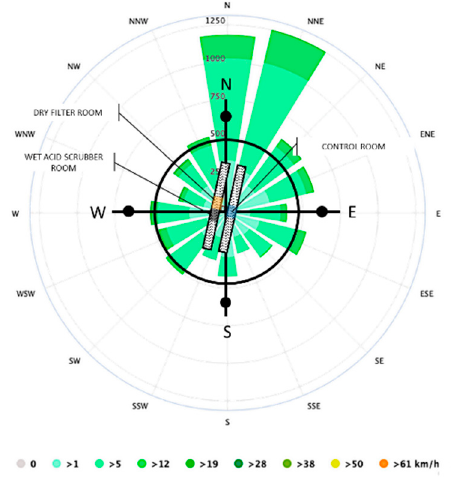
Figure 1. Orientation of the barns and prevailing winds.